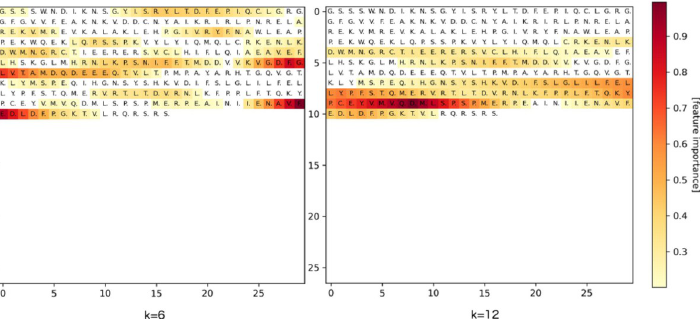
Fig 8. An example of a visual explanation generated by Grad-CAM for a CPI prediction made by our model. The CPI occurs between the protein PERK and the ligand 3Z1 (PDB ID 4X7J). The left plot corresponds to the model trained with kernel size k = 6 and the right plot to a model with kernel size k = 12. The darker the residues are, the more importance these amino acids contribute to the prediction.